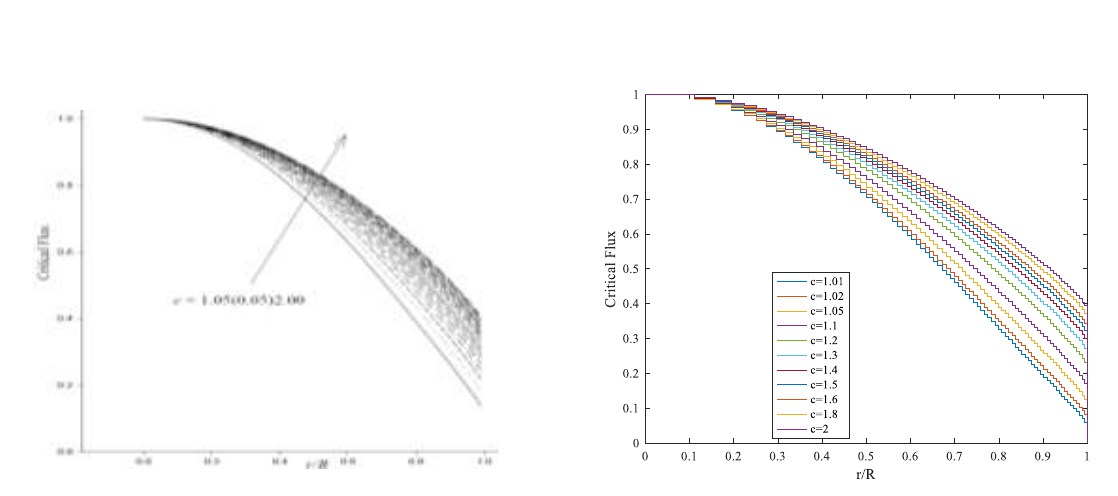
Figure 6. Reference critical flux distributions Figure 7. Normalized critical flux